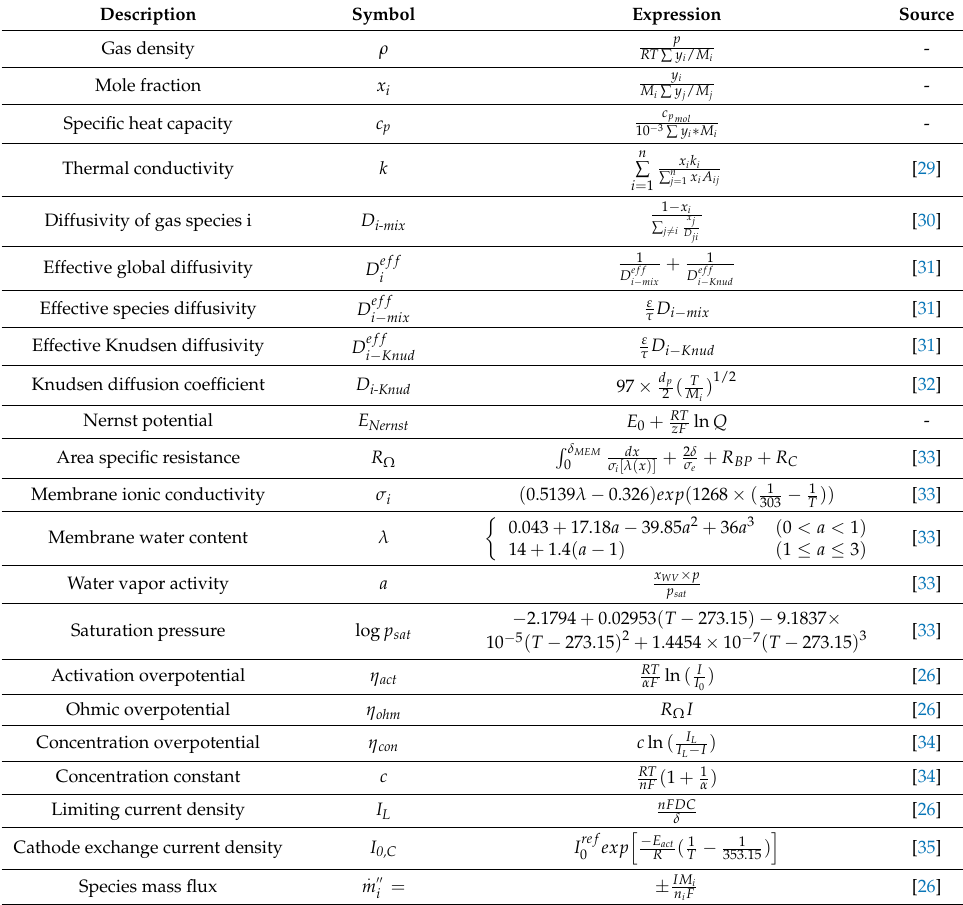
Table 2. Constitutive equations.